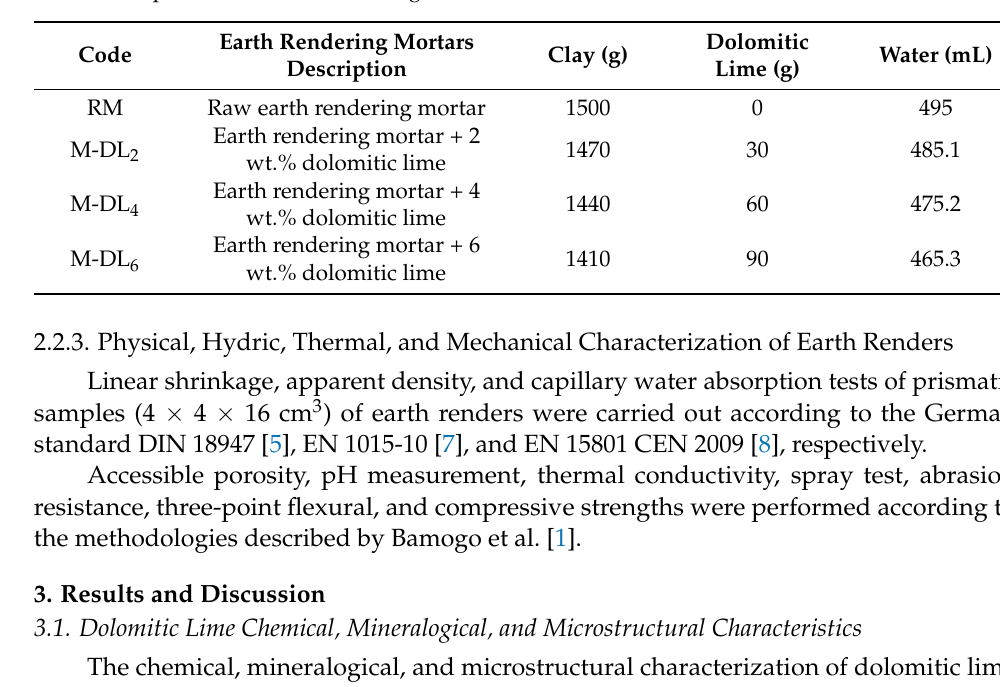
Table 2. Proportions of earth rendering